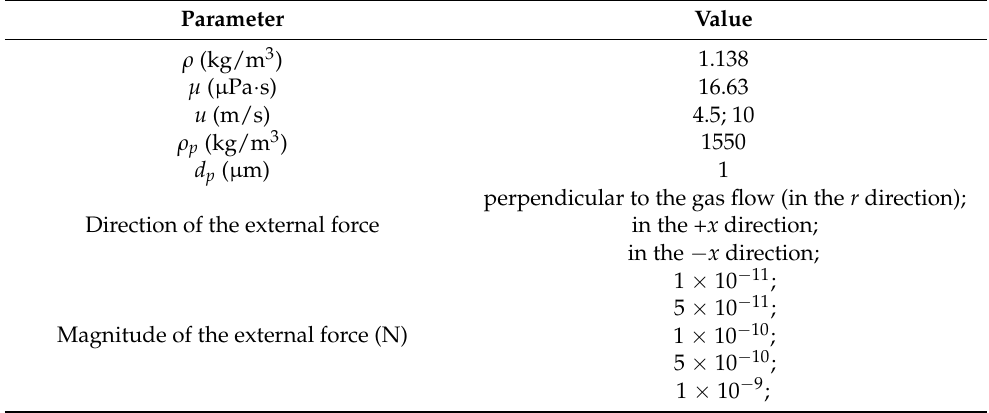
Table 1. The flow conditions, the properties of the gas, and the aerosol particles. Parameter